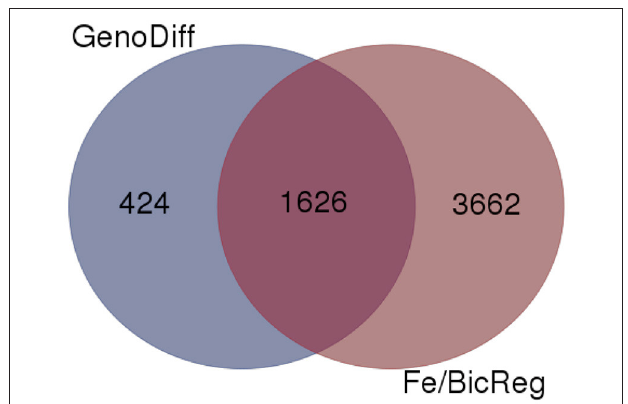
FIGURE 6 | Venn diagram comparing genes with differential expression in a specific condition (low or normal Fe supply with 0, 2.5, or 5mM bicarbonate) between IDC sensitive and tolerant lines (GenoDiff) to genes that responded to low Fe and/or bicarbonate in either line (Fe/BicReg). The 1,626 overlapping genes are featured in Supplementary Table 4 .